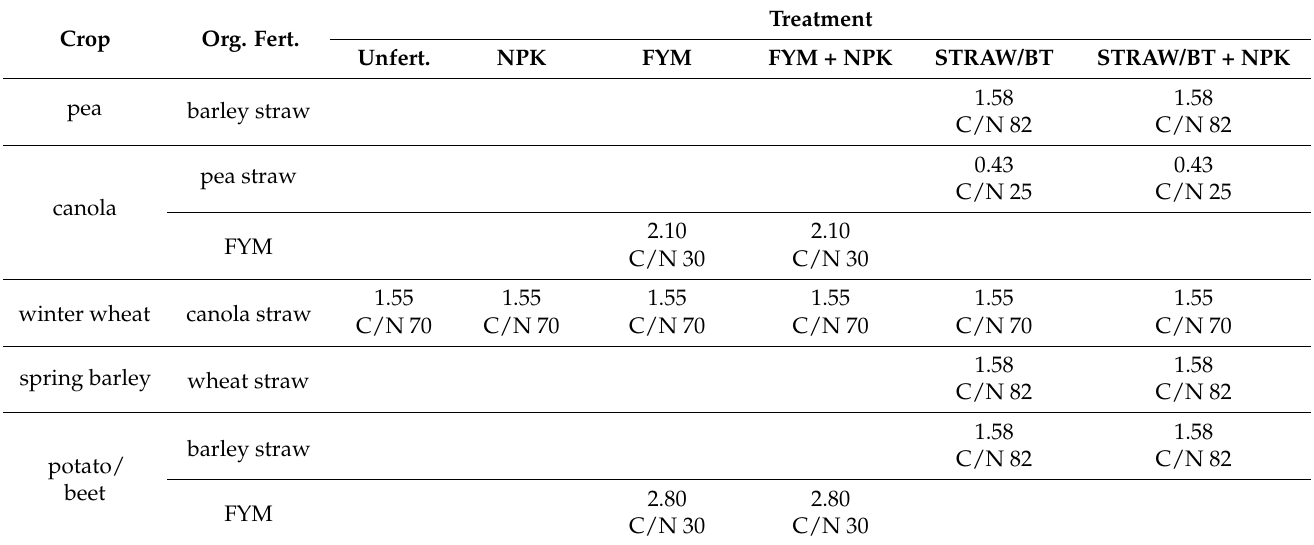
Table 2. Carbon input (t/ha) and C/N ratio of organic fertilizers applied in the individual treatments. Crop Org.